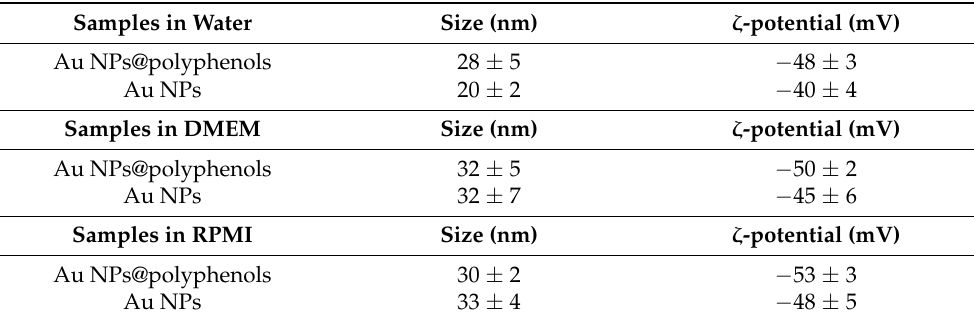
Table 2. Characterization of Au NPs@polyphenols and Au NPs (achieved by conventional chemical route) in water, DMEM, and RPMI by DLS and ζ -potential (mV)